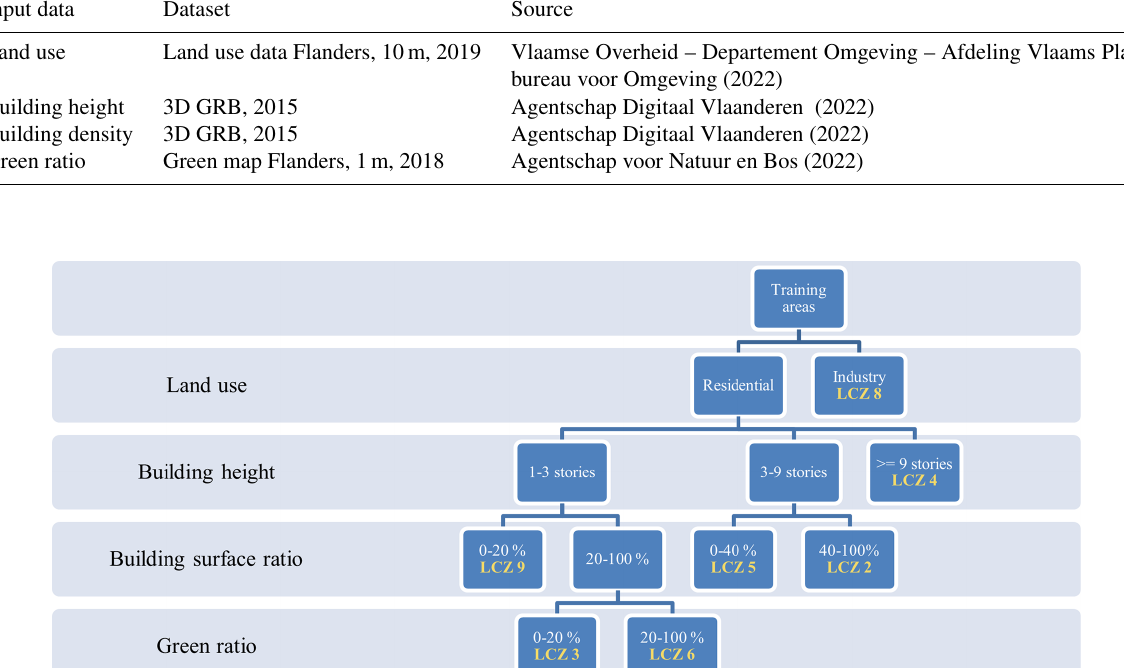
Earth Syst. Sci. Data, 14, 4681–4717,